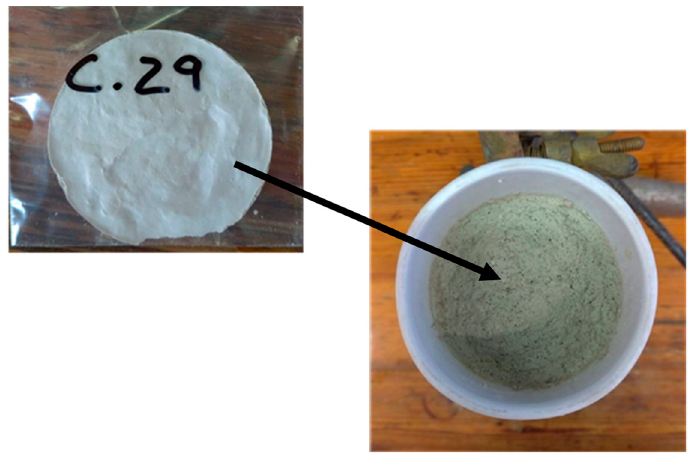
Figure 1. Example of porous monolith at the end of the process